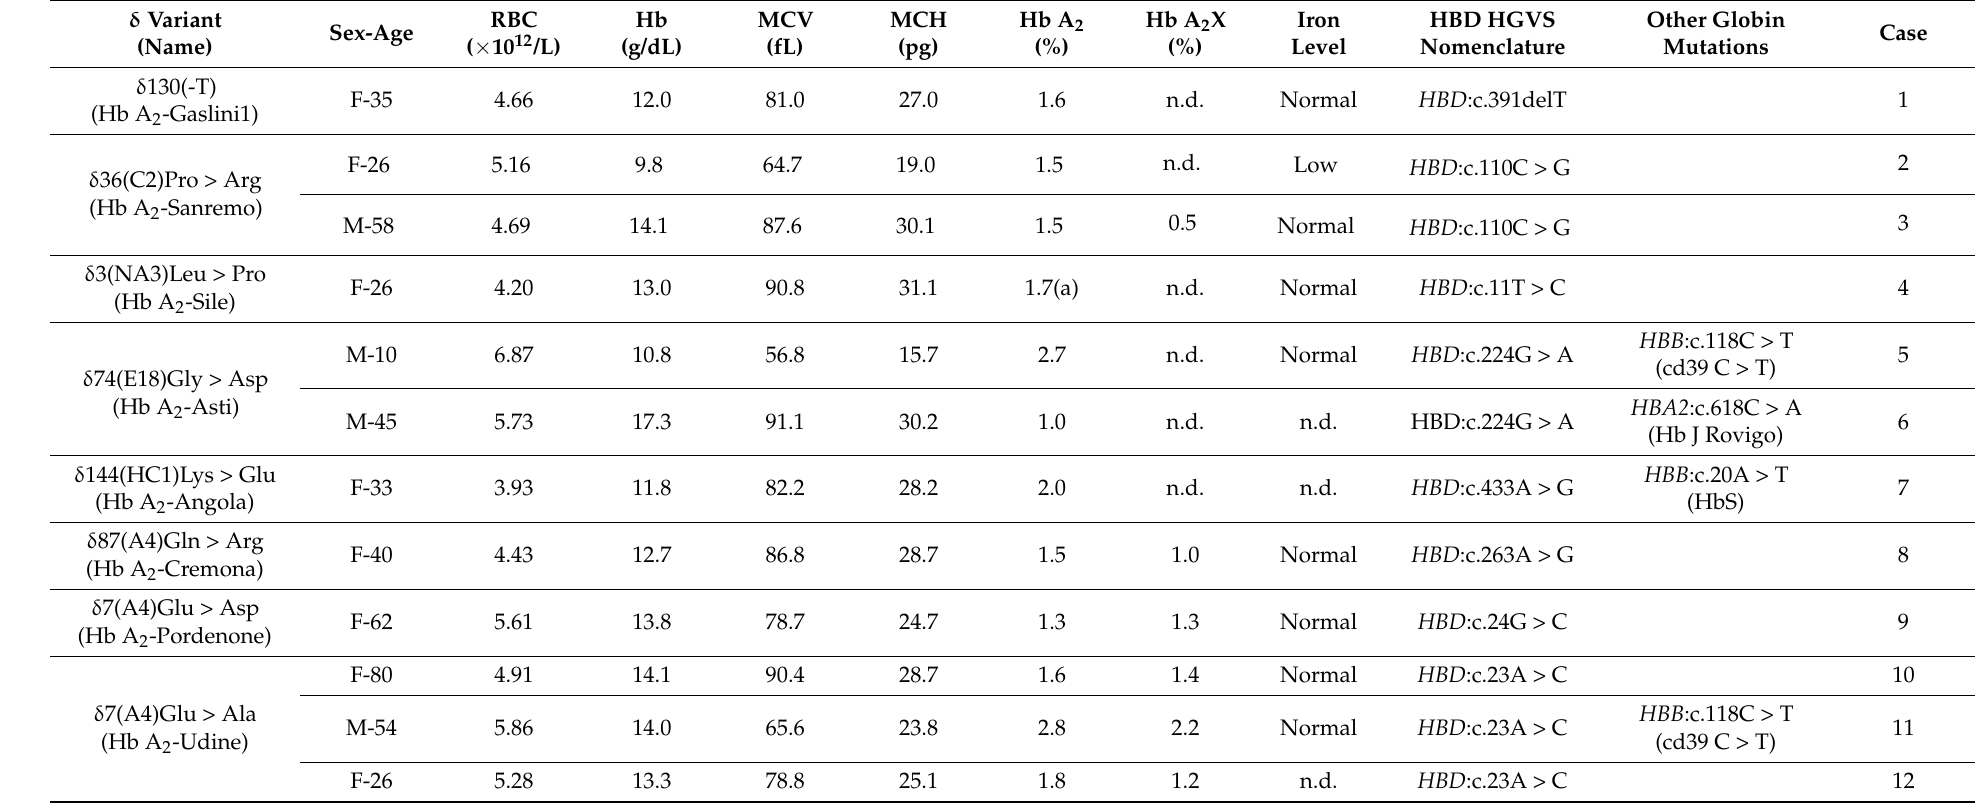
Table 1. Hematological data and molecular results of the 8 new mutations of the δ -globin gene found in 12